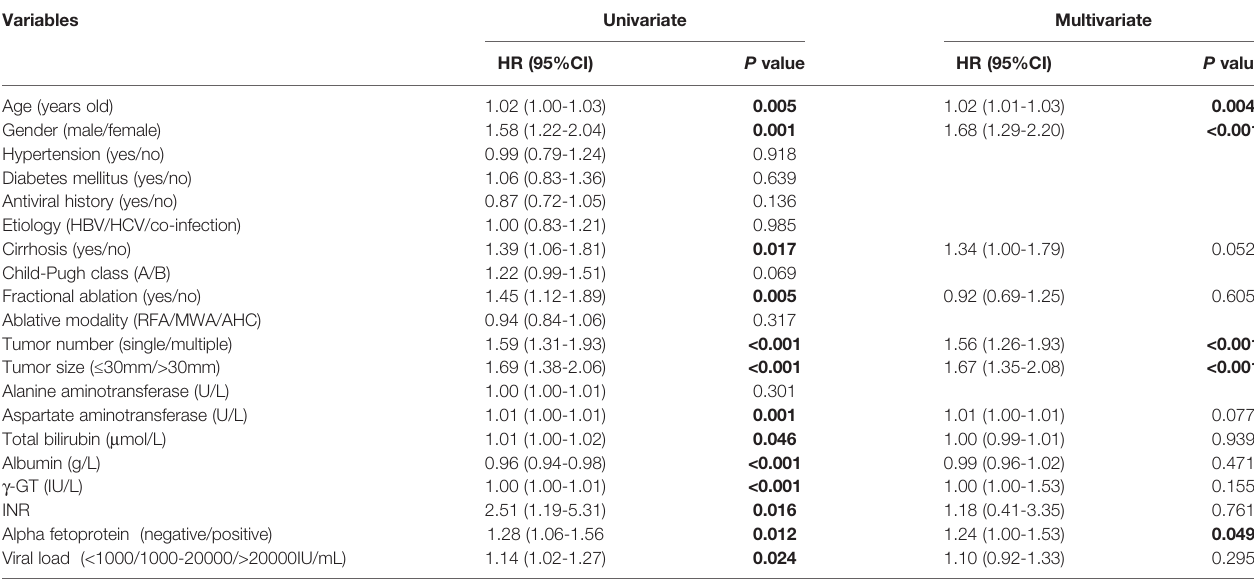
TABLE 2 | AFP at baseline as a prognostic factor associated with RFS. Variables